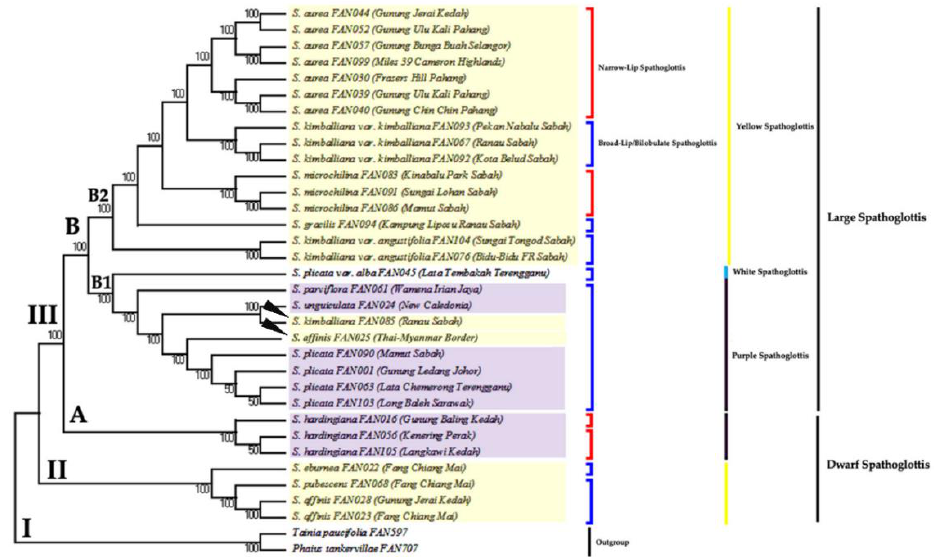
Figure 7. The consensus tree inferred from two equally parsimonious trees via MP analysis of genus Spathoglottis based on combined plastid and nuclear gene dataset. Number below branches are bootstrap percentages ≥ 50. Branches corresponding to partitions reproduced in less than 50% trees are collapsed. Tree length = 695; consistency index, CI = 0.709; retention index, RI = 0.906; and composite index, RC = 0.711 (0.643) for all sites and parsimony-informative sites (in parentheses). Clade I indicates outgroup. Clade II comprises of the Dwarf Yellow Spathoglottis group, as sister to all Spathoglottis species. Clade III holds the Dwarf Purple Spathoglottis group (Subclade III-A), Large Purple Spathoglottis group (Subclade III-B1) and Large Yellow Spathoglottis group (Subclade III-B2). The Large Spathoglottis group (Clade III-B) is